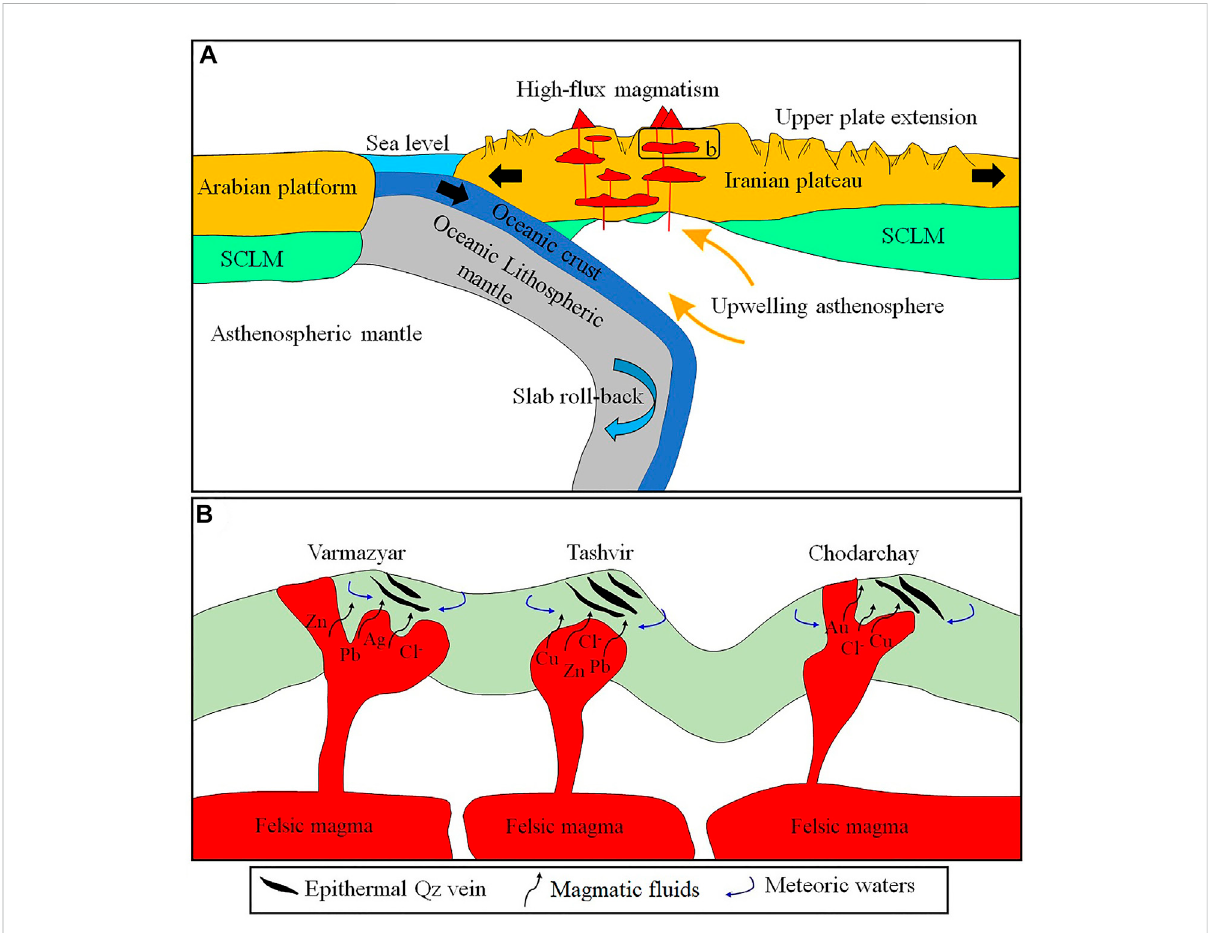
FIGURE 12 (A) . Schematic cartoon for subduction, slab roll-back, extension, and magmatism in NW Iran (including THMB) during the Eocene time (based on Verdel et al., 2011; Shafaii Moghadam et al., 2018; Mokhtari et al., 2022b). (B) . Cartoon showing the type of fl uids involved in the formation of the epithermal mineralization in the